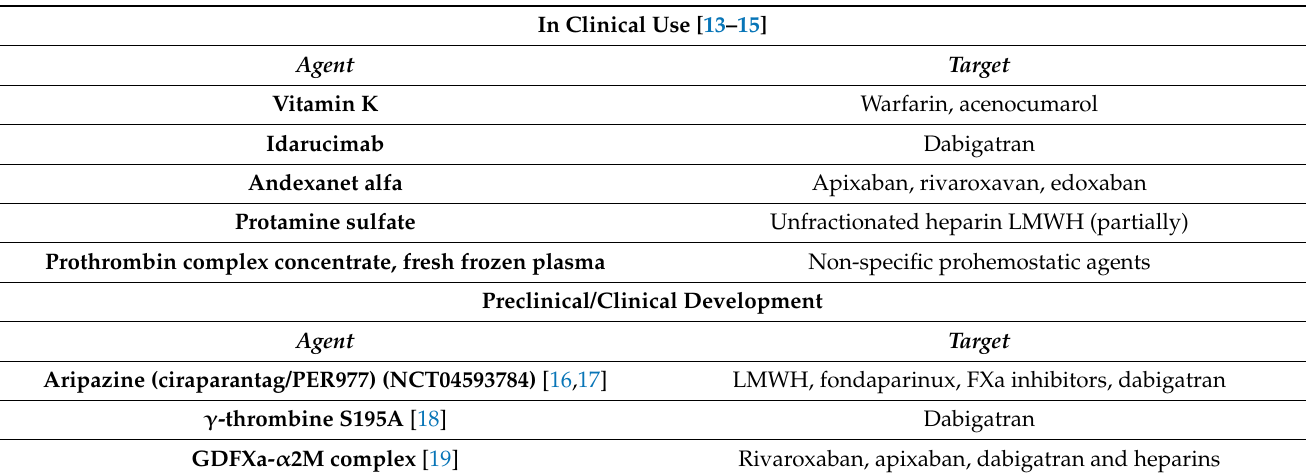
Table 1. Anticoagulant reversal agents in clinical use and preclinical/clinical development.